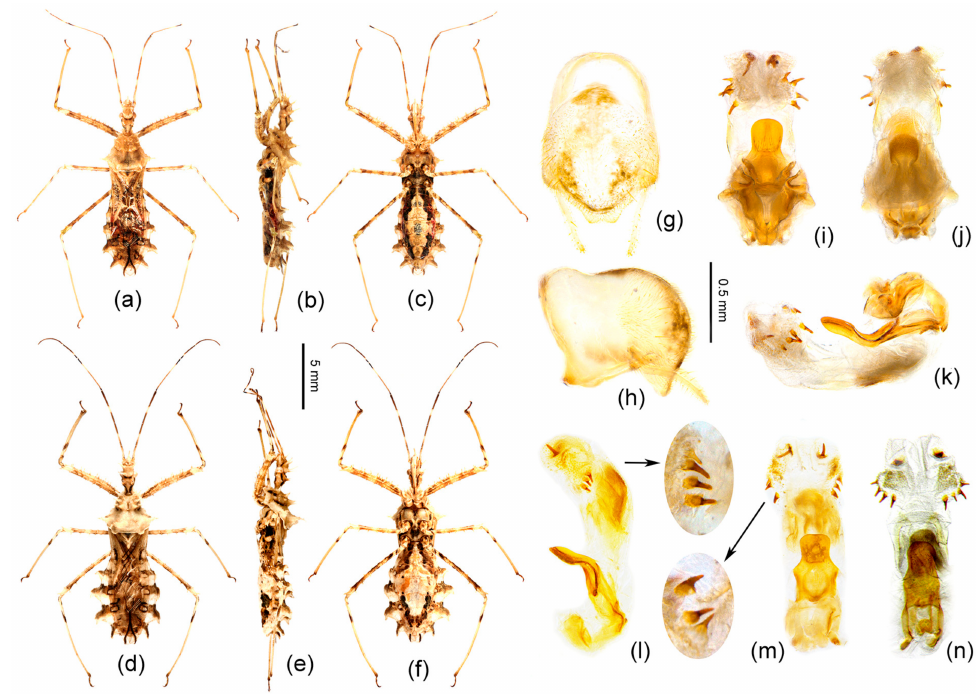
Figure 11. Sclomina xingrensis sp. nov., ( a – c ) male, ( d – f ) female, GZXR, habitus; ( g – k ) male, GZXR1, male external genitalia; ( l – m ) male, GZXR2, male external genitalia; ( n ) male, GZLS1, male external genitalia. ( g , h ) pygophore with paramere; ( i – n ) phallus. ( a , d , i , m , n ) dorsal view; ( b , e , h , k , l ) lateral view; ( c , f , g , j ) ventral view. Scale bar of ( a – f ) = 5 mm, ( g – n ) = 0.5 mm. The sub-apical spines of ( l , m ) are